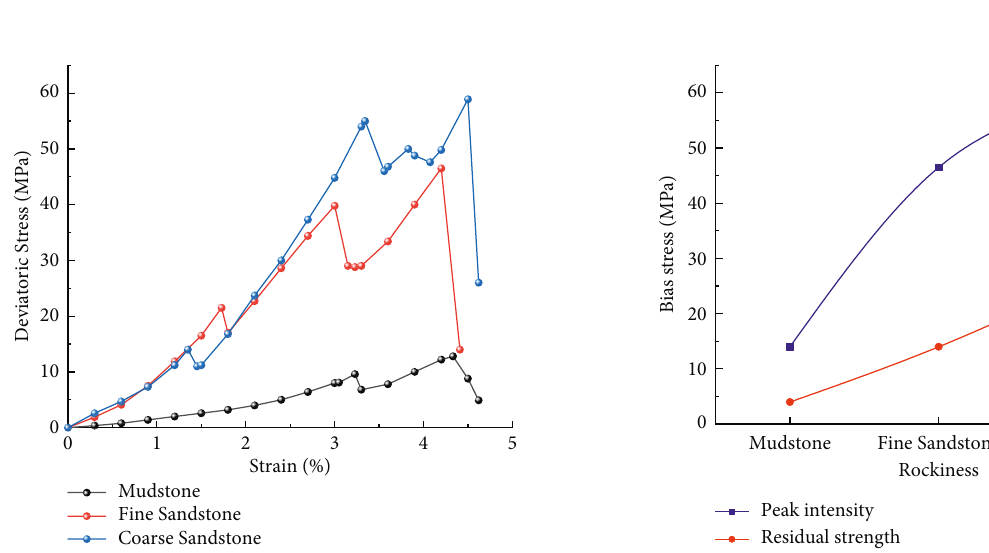
Figure 9: Slippage and macroscopic failure characteristics of joint plane with different roughness: (a) fine sandstone with fine sand, (b) fine sandstone with medium sand, and (c) fine sandstone with coarse sand.